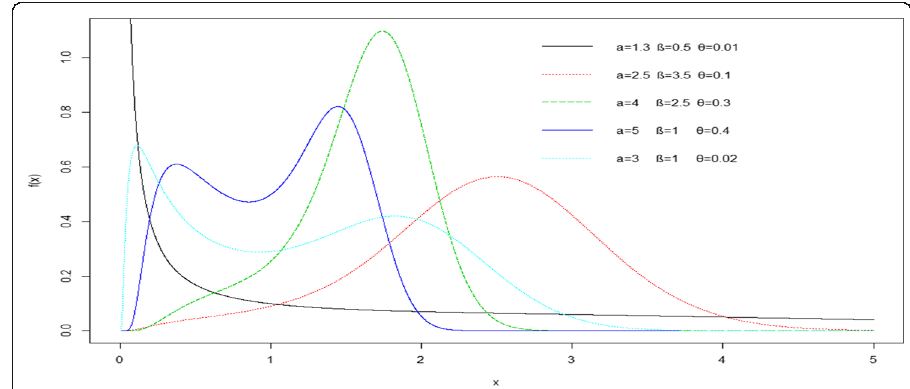
Fig. 1 GUWELOP density for varying parameter values ( λ = 1, γ = 6)